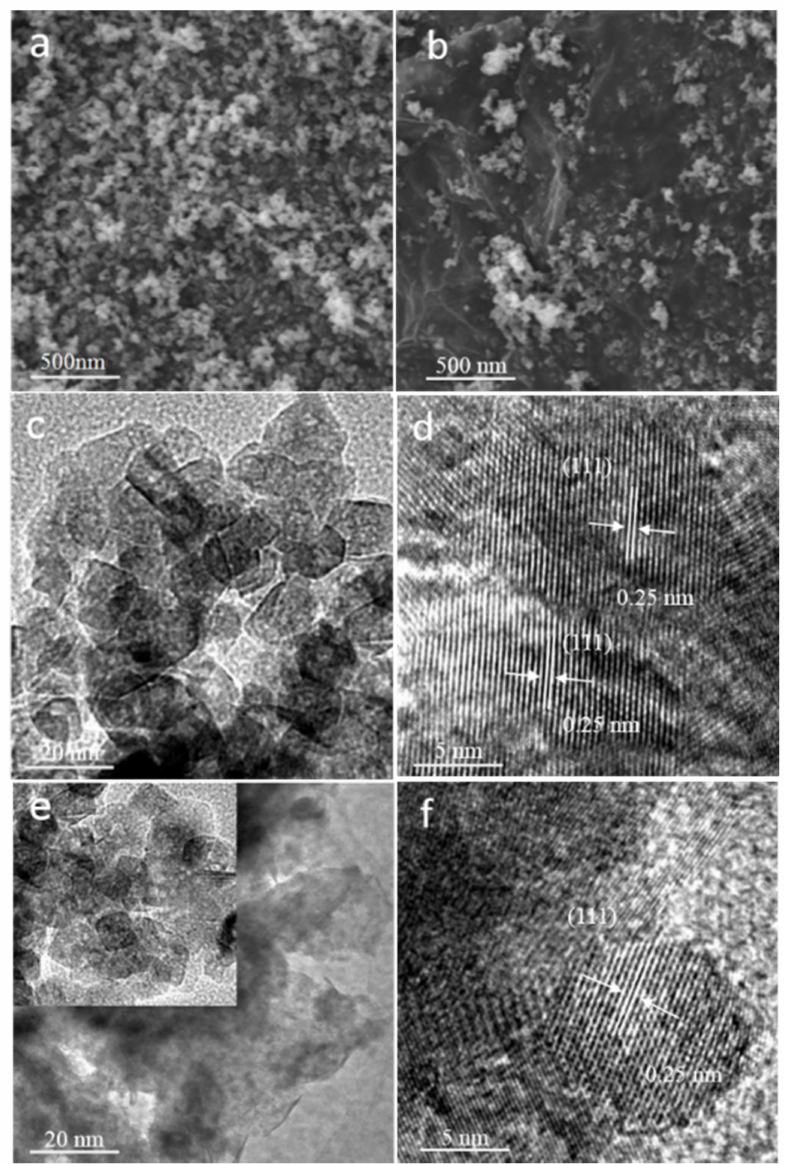
Figure 1. SEM images of ( a ) CuO and ( b ) CuO/G. TEM images of ( c ) CuO and ( e ) CuO/G. HRTEM images of ( d ) CuO and ( f )